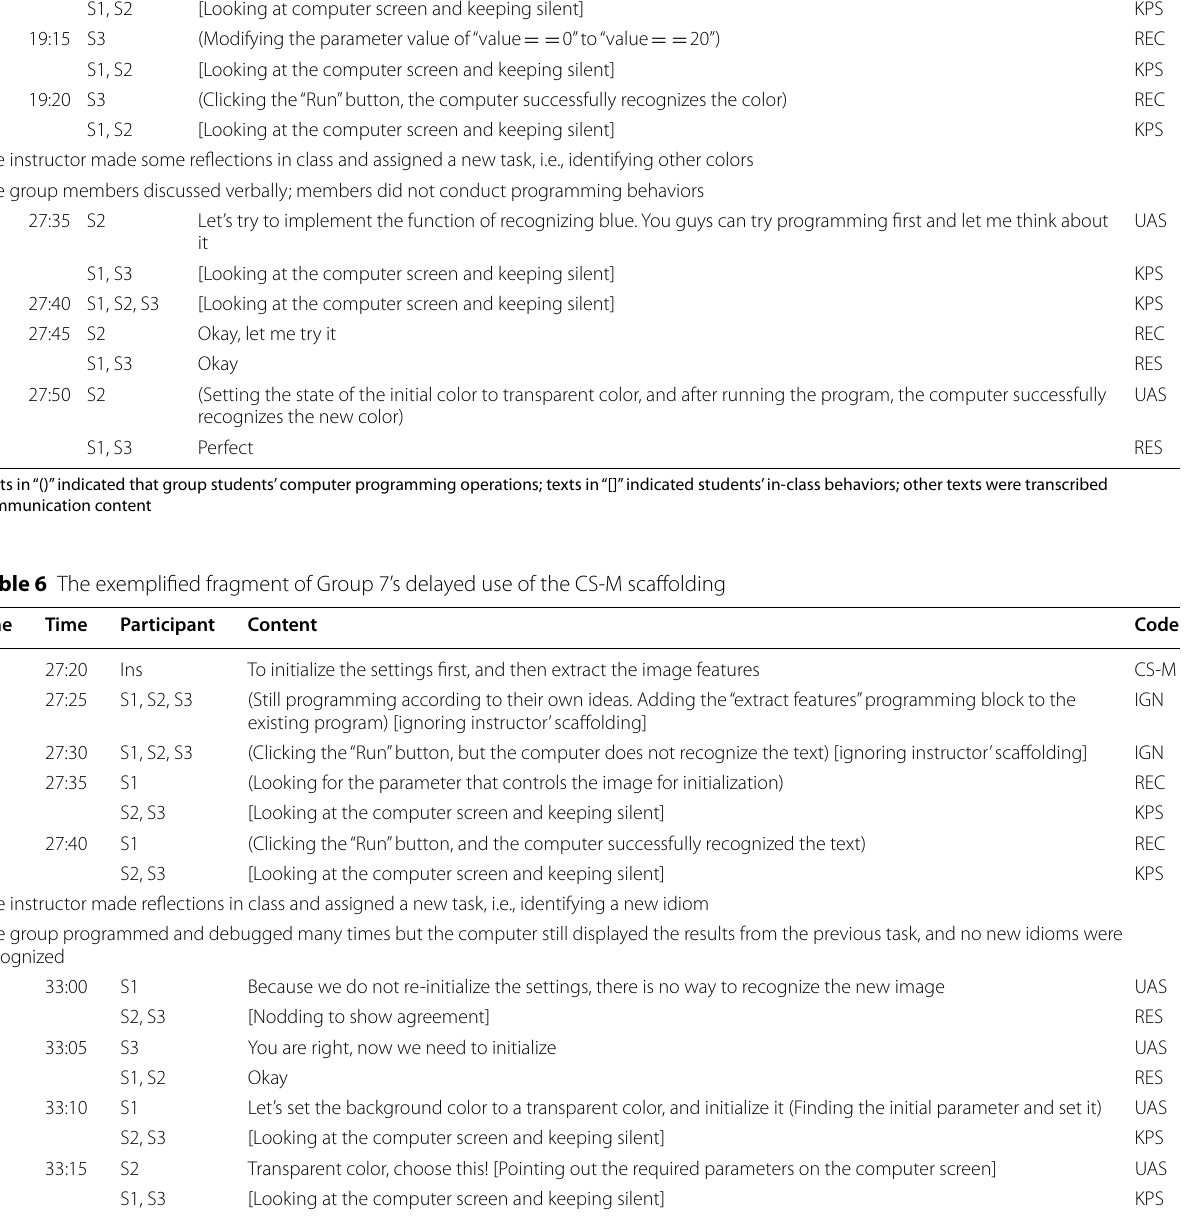
Table 5 The exemplified fragment of Group 8’s delayed use of the MS scaffolding